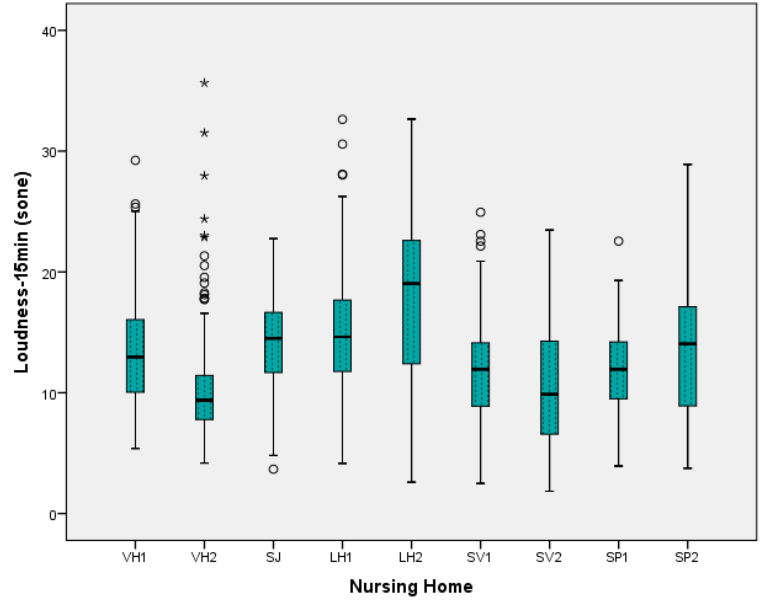
Figure 9. Distributions of Loudness -15min scores as a function of the living rooms.